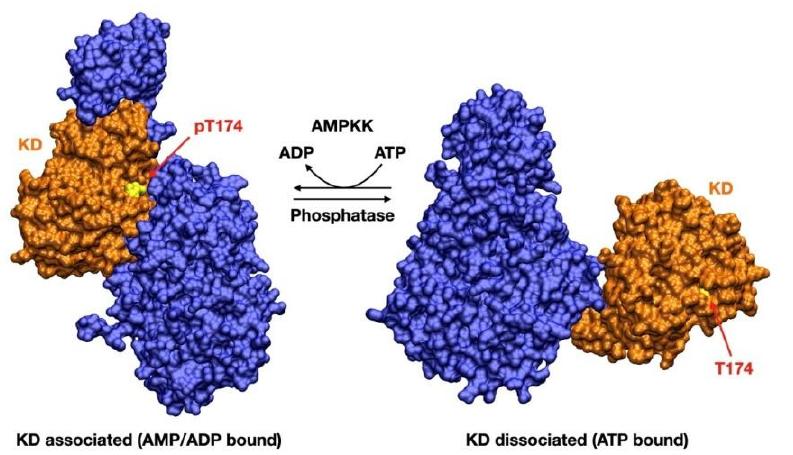
Figure 3. Displacement of the kinase domain (KD) from the associated, active (AMP/ADP bound) conformation. Disassociation is triggered by the substitution of an AMP/ADP residue with Mg- ATP 2 − one: this brings to a steric clash with the protecting α RIM2 loop, favoring the disassociation of the KD. Phosphorylated Thr-174 (Thr-172 in α 2) thus finds itself in an unprotected state, allowing its subsequent dephosphorylation, which in turn inactivates AMPK [4,7,9]. The structures used were 4RER [4] for the associated, active state and 7JHG [9] for the disassociated, inactive state. The ability of the γ subunit to bind AMP, ADP, and ATP allows AMPK to sense the energy state of the cell. Under conditions of high AMP:ATP ratio, AMPK phosphorylates